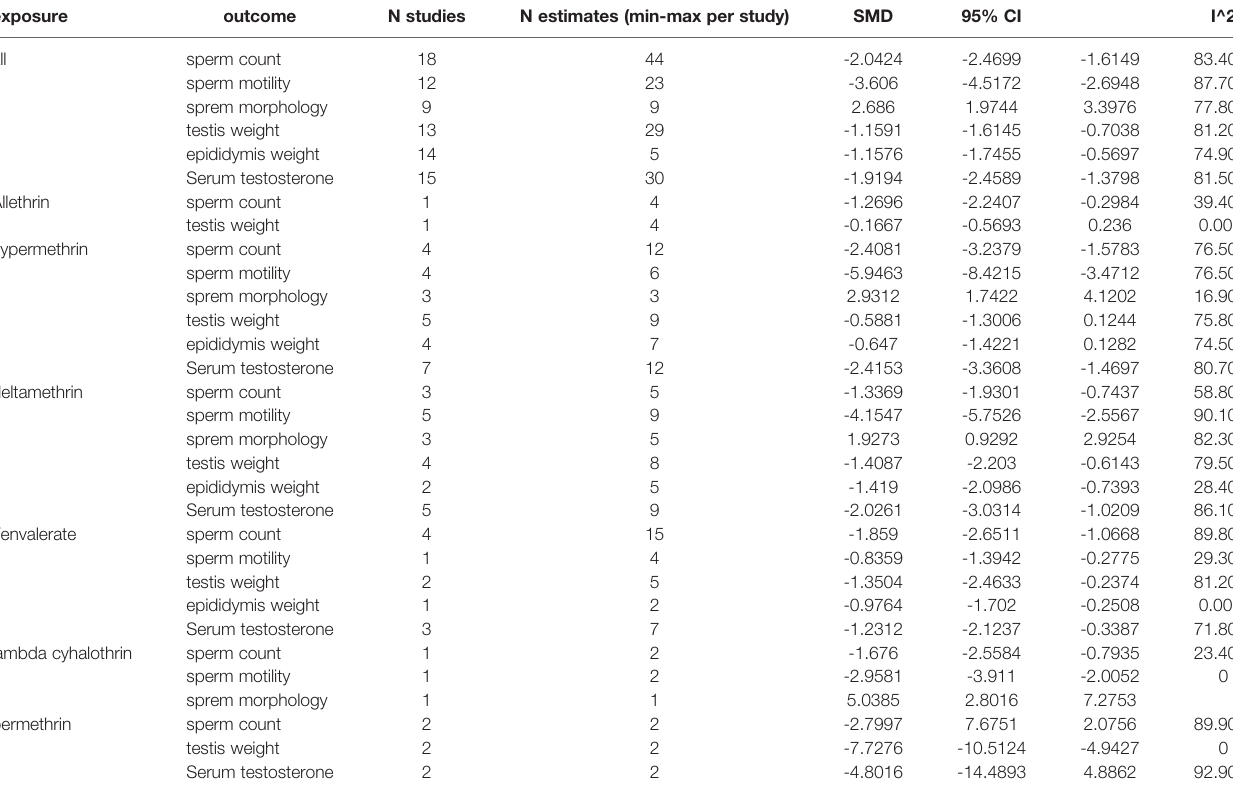
TABLE 1 | The effect of pyrethroid exposure on rats. exposure